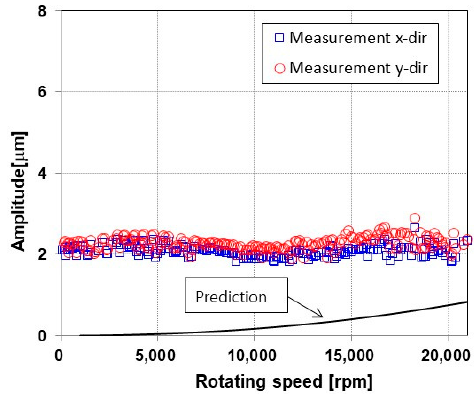
Figure 14. Measured and predicted rotor vibration at the turbine side bearing.